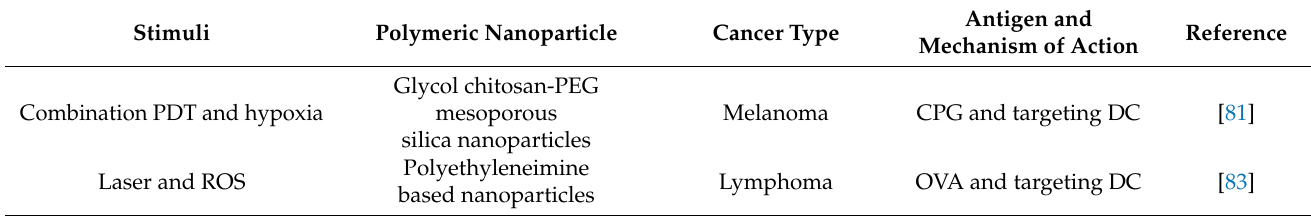
Table 4. Exogenous stimuli-based polymer nanoparticles for delivery of